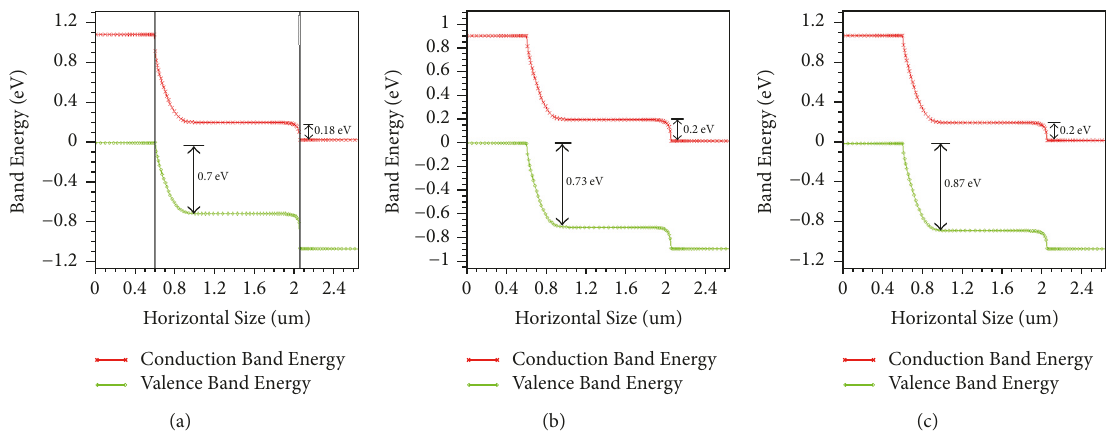
Figure 4: The band simulation of three type modulation structures: (a) Si/SiGe/Si-OI structure, (b) SiGe-OI structure, and (c) SOI structure.